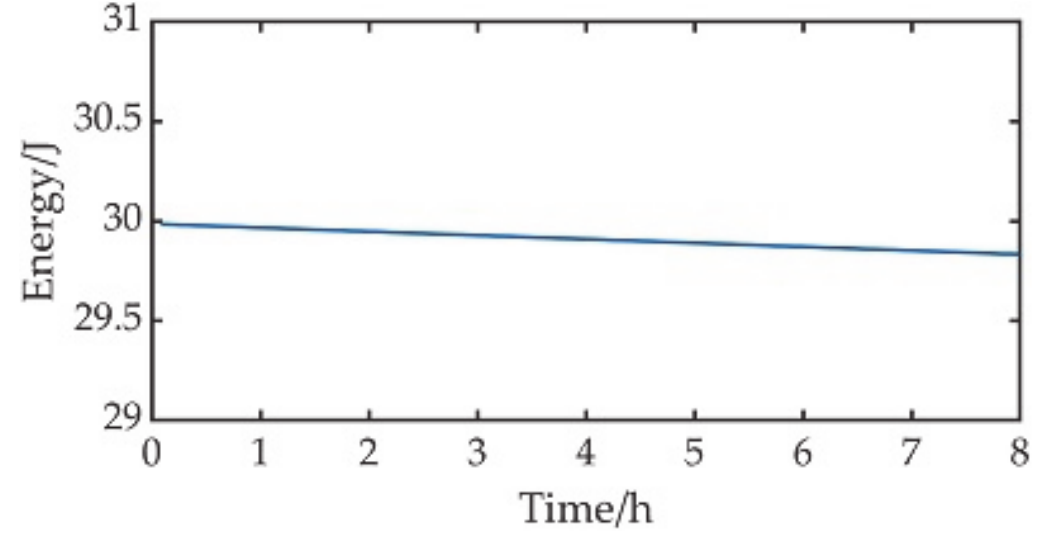
Figure 8. Simulation results of total energy received by PD over time in Experiment 2.